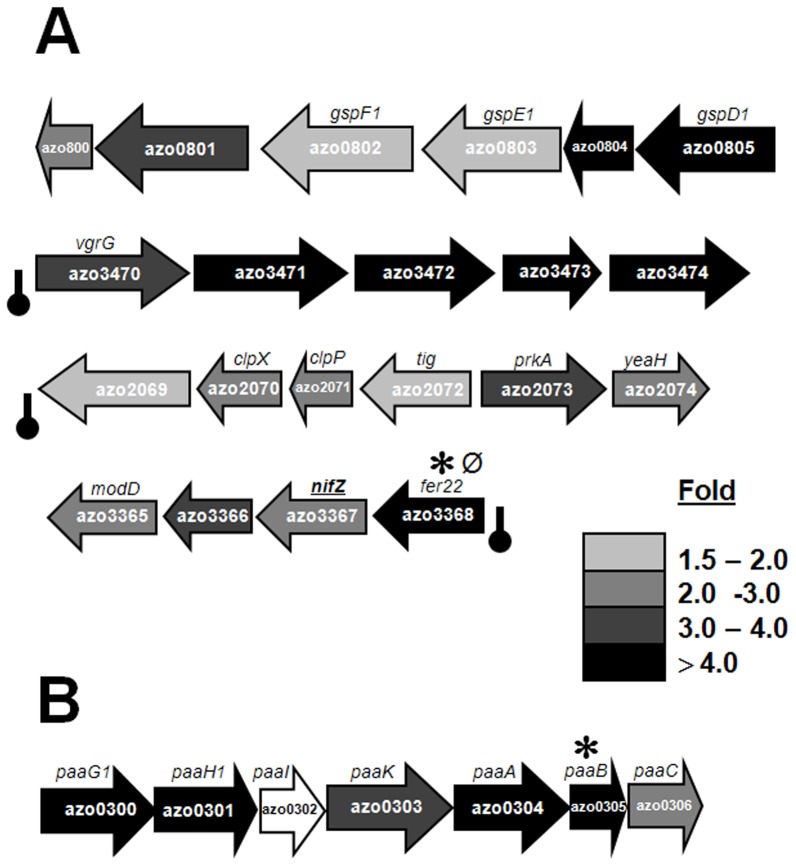
Selected gene clusters up-regulated or down-regulated under N2 fixation in comparison to growth on ammonia.(A) Clusters up-regulated, with following functions: gene cluster encoding for components of general secretion pathway (type II); cluster encoding for several hypothetical proteins, the first gene in the cluster being vgrG (component of type VI secretion); cluster of genes encoding for proteases; cluster harboring genes involved in nif maturation, nifZ, ferredoxin like mobile electron carrier fer22, and component of Molybdenum transport modD; closely linked genes within the nif cluster encoding for FeMoco cofactor biosynthesis protein, hypothetical protein, sigma E factor regulatory protein and probable ferrodoxin. (B) Cluster down-regulated under N2 fixation; genes encoding for proteins/enzymes involved in phenylacetic acid degradation pathway (paa). Fold change represented by shades of grey give the average fold of induction from 3 independent microarray experiments in each case. Black bar with round cap, symbols ∗ or Ø, represent intergenic transcription termination loop, putative RpoN-binding sites or putative NifA-binding sites, respectively, upstream of the target gene of interest as described previously in the legend of Figure 2.